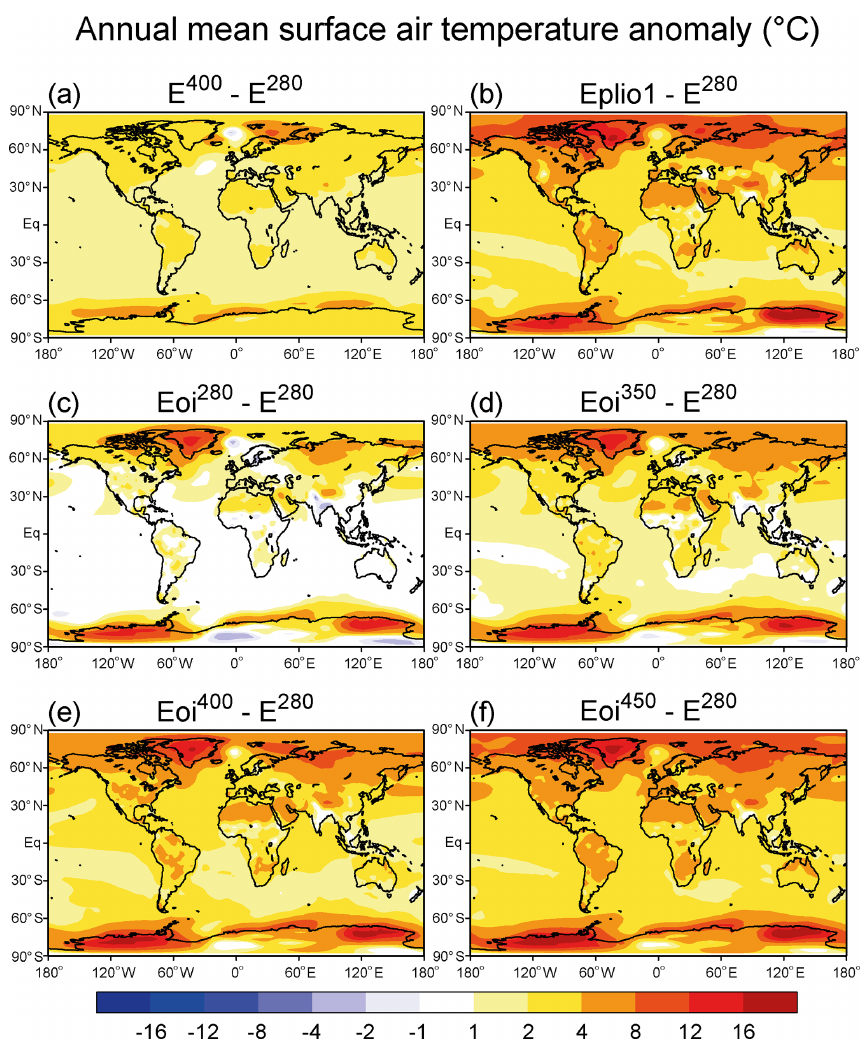
Figure 3. Annual mean surface air temperature anomaly between six experiments and E 280 , the pre-industrial one. For a comparison of PlioMIP1 and PlioMIP2, see (b, e) . For the individual effects of CO 2 and Pliocene boundary conditions, see (a, c) ,